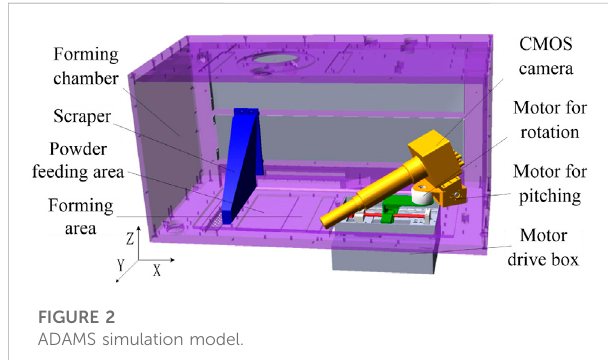
FIGURE 2 ADAMS simulation